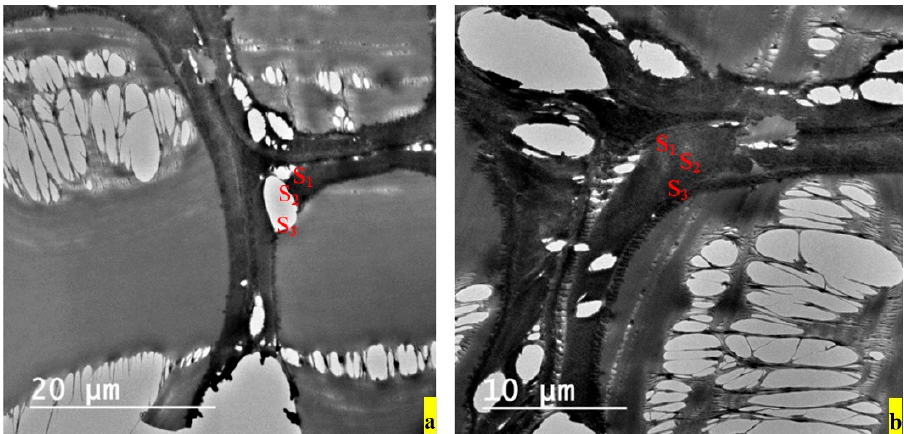
Figure 4. TEM photos ( a , b ) of wood samples infected with Fusarium showing soft-rot decay type II (erosion), starting from the S 2 layer and extending to the S 1 layer. The general apparent lacerations result from sectioning.